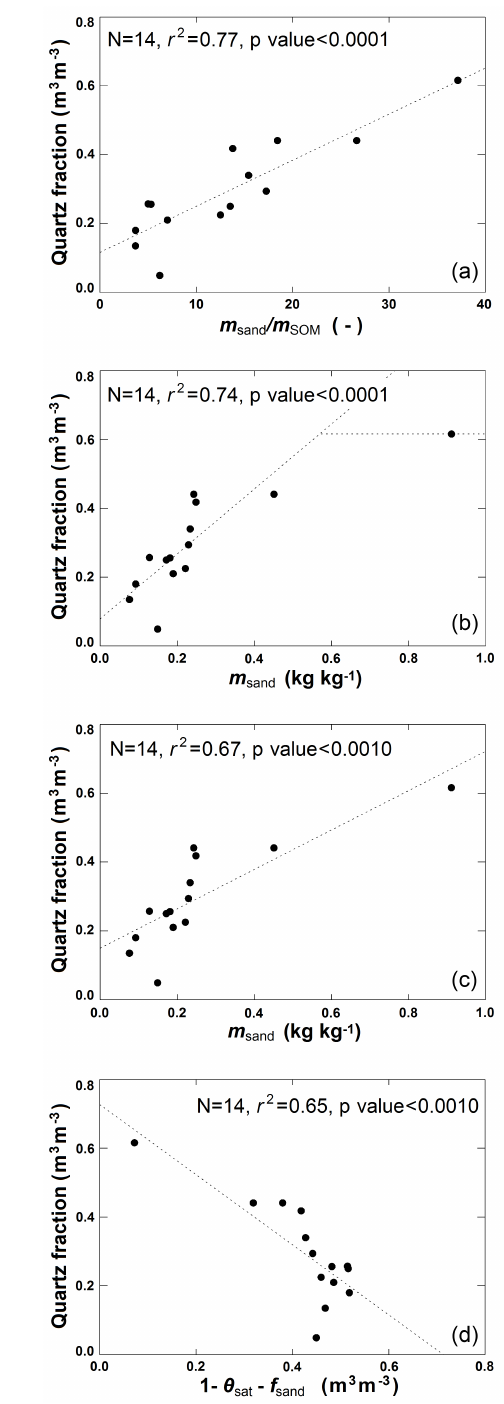
Figure 6. Pedotransfer functions for quartz: f q retrievals (dark dots) vs. the four predictors of f q given in Table 3. The modeled f q values are represented by the dashed lines.